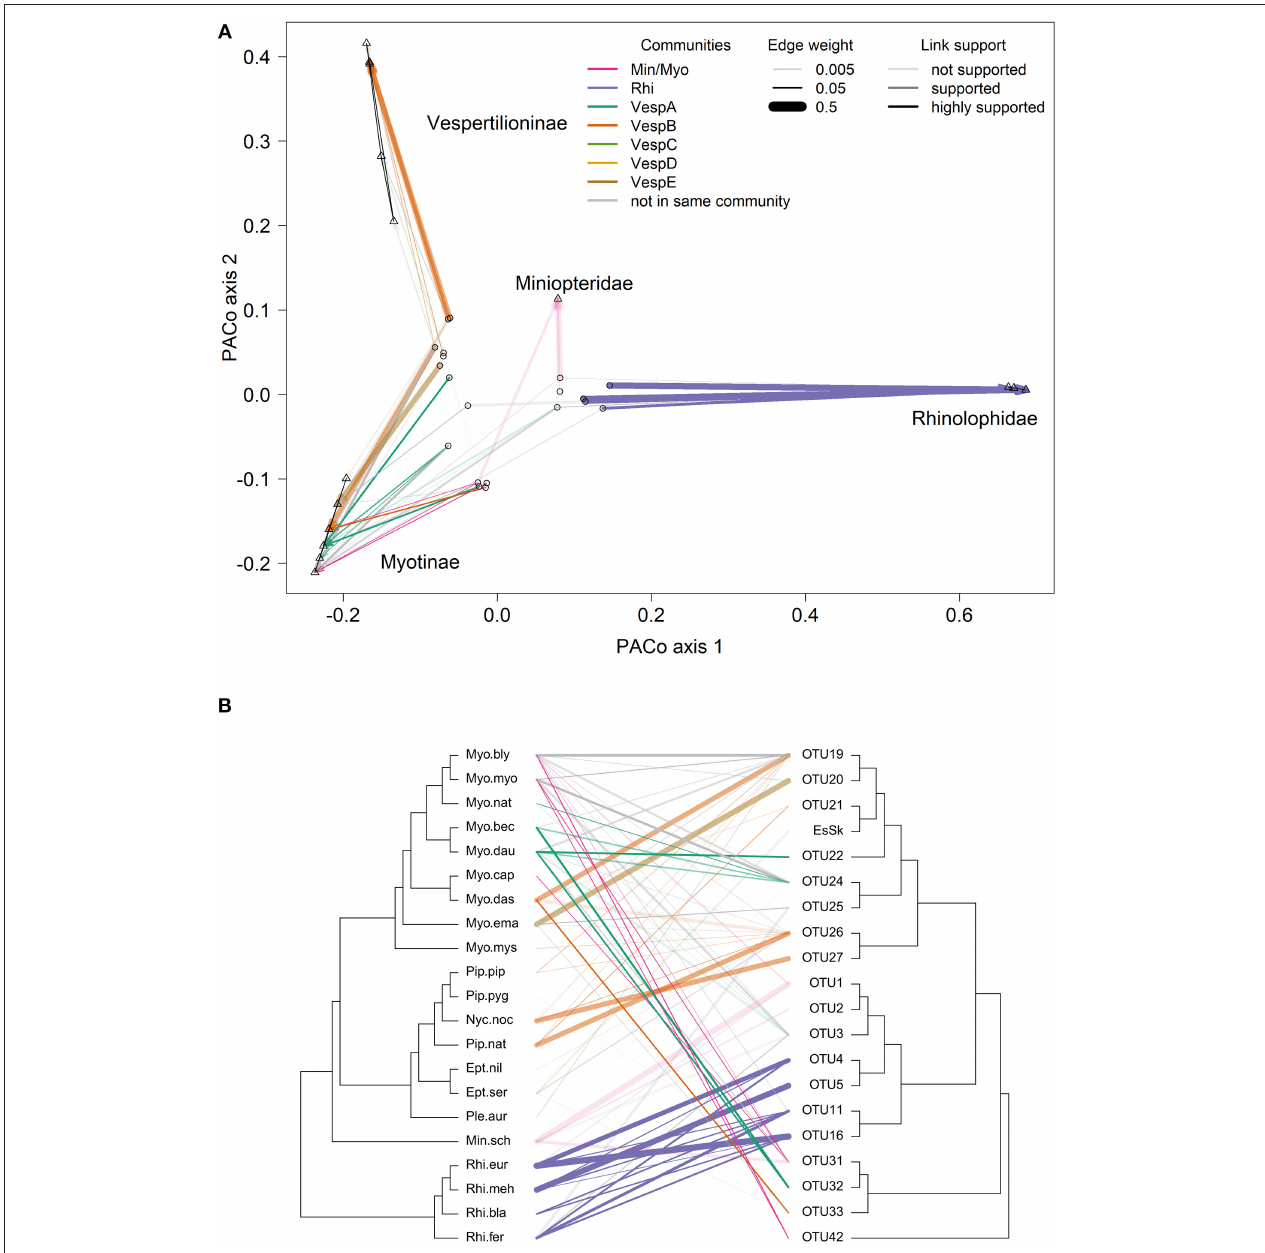
FIGURE 5 | Comparisons of bat species and Bartonella OTU phylogenies. (A) Procrustes superimposition plot with Bartonella OTUs (open circles) and bat species (open triangles). In this plot, the axes represent the principle components of the bat species phylogeny. Bat species are projected onto the two main axes explaining the most variation. Names of bat families and subfamilies are indicated for clusters of species. The Bartonella OTUs are then projected and rotated to fit the bat phylogeny by minimizing the residual distances for each bat-Bartonella association (connected by lines). (B) Cophylogeny plot with the bat species phylogeny on the left side and the Bartonella OTU phylogeny on the right side. Lines in the middle connect bat species to Bartonella OTUs based on sequence data collected from bats or associated ectoparasites. Species abbreviations for bat species are listed in Table 1 . In both (A) and (B) , bat- Bartonella links colored by the community if both the bat species and Bartonella were placed in the same community (as in Table S14 ). Line widths in both (A) and (B) are proportional to network edge weight and the line transparency depend on the link support from PACo and ParaFit analyses.